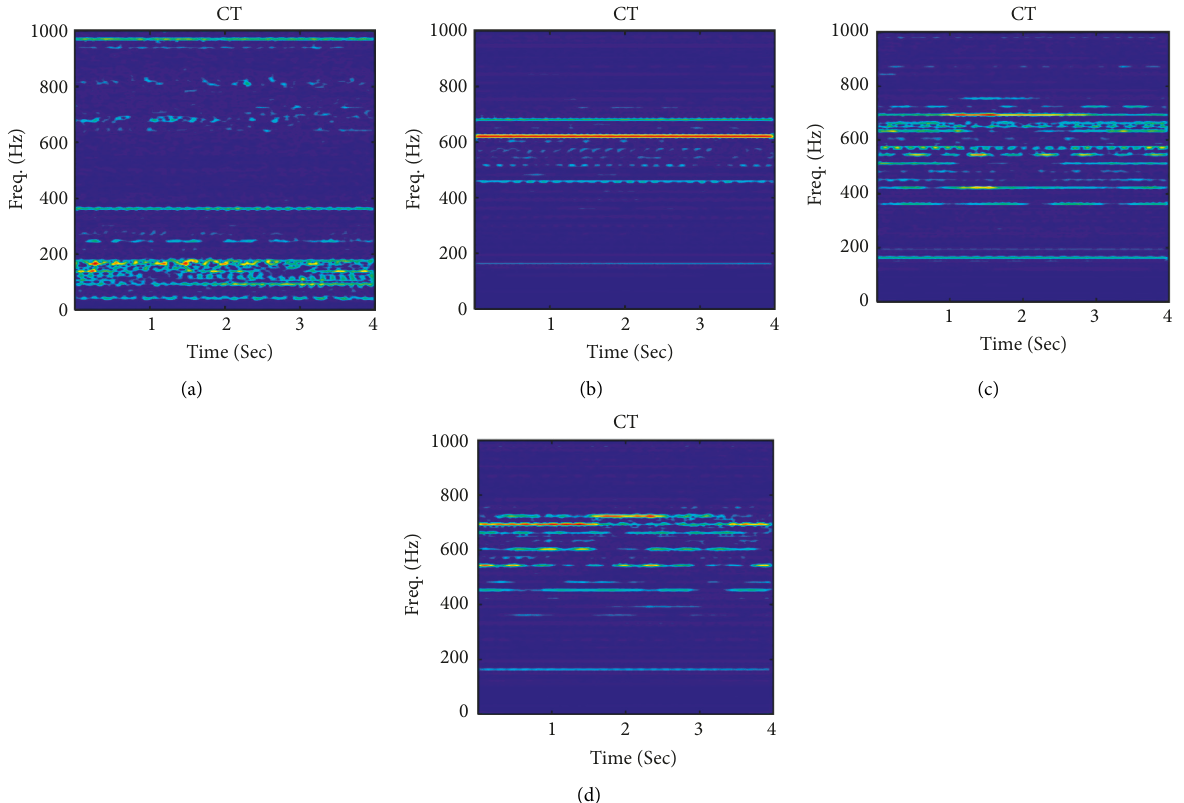
Figure 3: Chirplet time-frequency diagram of bearing in different conditions. (a) Normal bearing. (b) Inner-race fault. (c) Roller fault. (d) Outer-race fault.